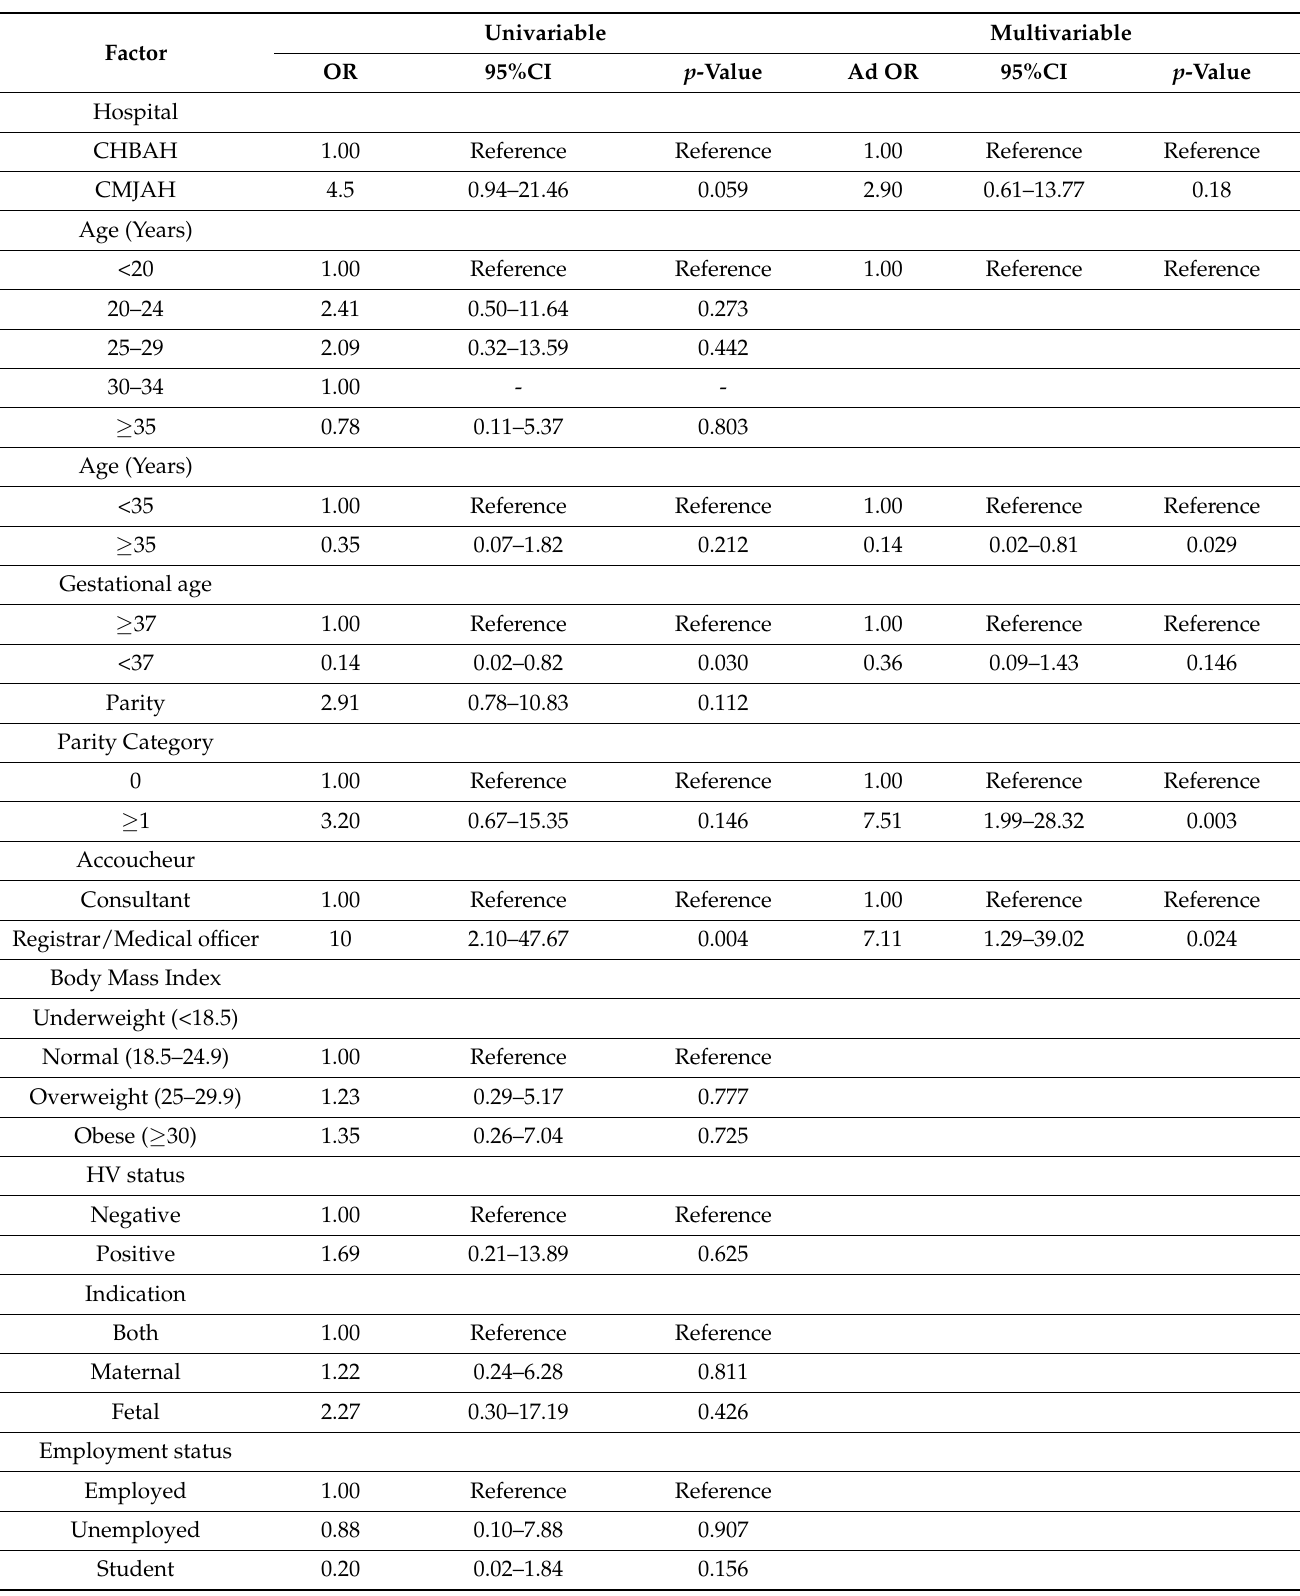
Table 5. Univariable and multivariable regression of the association between sociodemographic and clinical characteristics and vacuum delivery among women who had operative vaginal